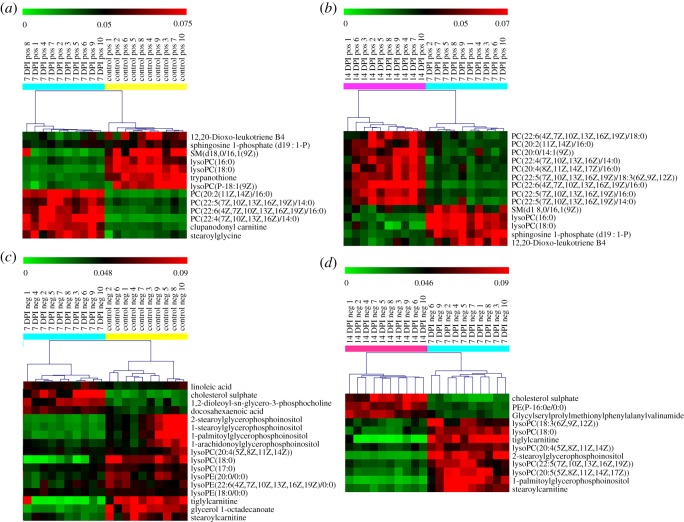
Heat maps of the significantly differential metabolites. Hierarchical clustering was used to separate individual samples (X-axis). Y-axis represents compounds. Metabolomic profile between different groups was shown a clear separation in the heat map. Normalized signal intensities are visualized as a colour spectrum in the heat maps. Red represents high expression, and green represents low expression of the dysregulated metabolites. Heat maps showcasing the significantly differential metabolites screened from the control group and 7 DPI group in positive (a) and negative (c) ion mode. Heat maps showcasing the significantly differential metabolites screened from the 14 DPI and 7 DPI group in positive (b) and negative (d) ion mode. Yellow colour represents control samples, cyan colour indicates 7 DPI samples and rose red colour indicates 14 DPI samples.